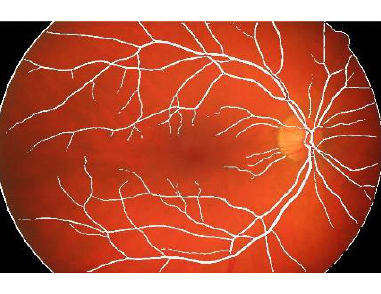
Figure 6.c. Output image